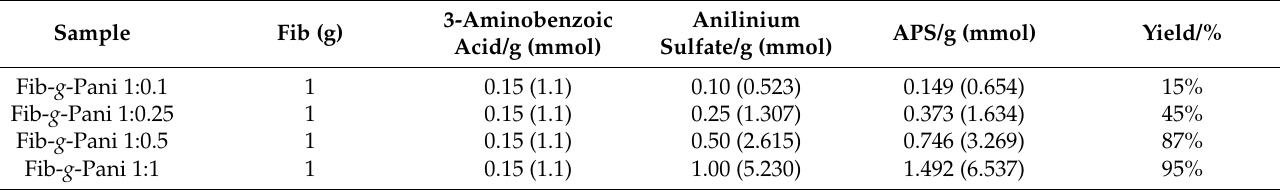
Table 1. Formulations employed for fibroin- g -PAni (Fib- g